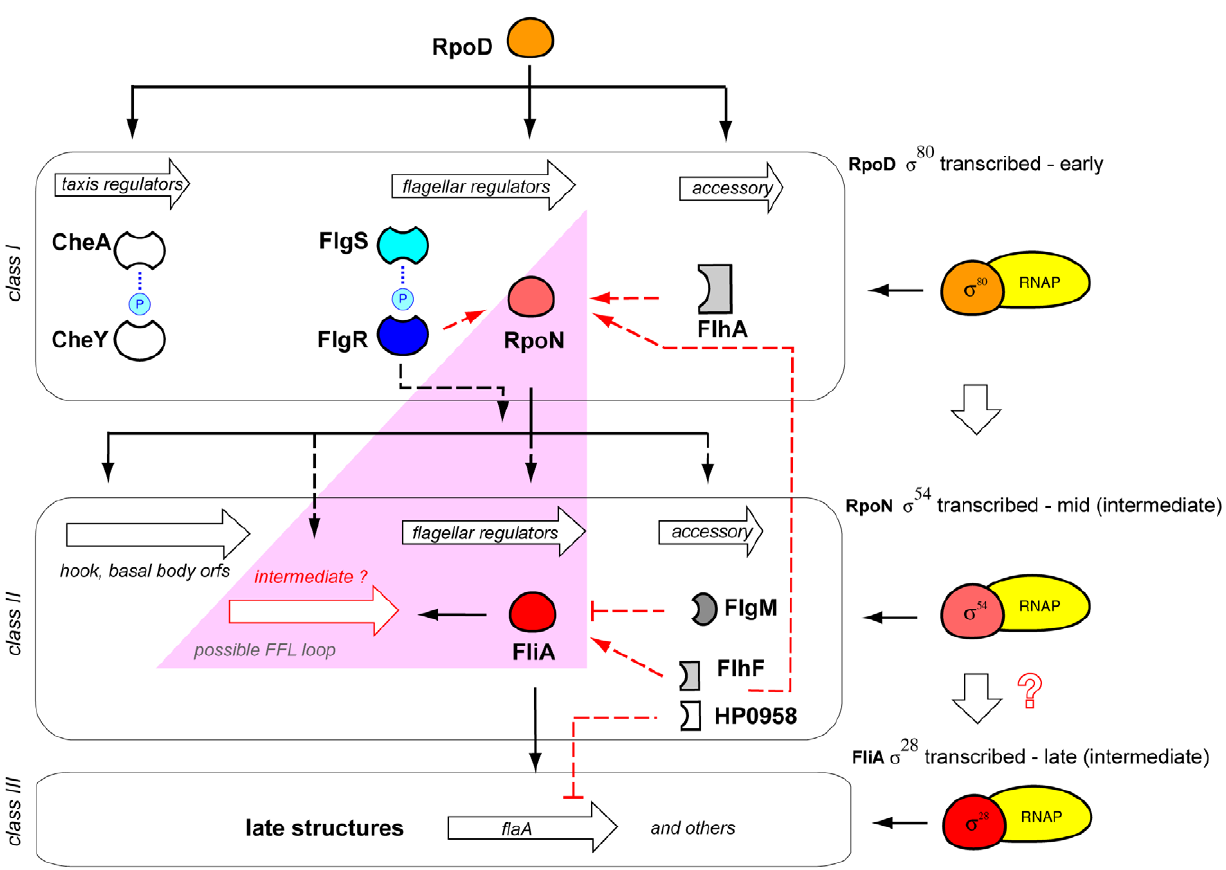
Figure 3. The flagellar biosynthesis module. RNAP, RNA polymerase; phosphorylation events are indicated by a light blue circle. CheAY, two component system involved in chemotaxis; FlgS, NtrB-like cytoplasmic histidine kinase; FlgR, NtrC-like response regulator. FlgM, anti- s 28 factor. FlhA, FlhF, HP0958: accessory factors. Note sequential activation of class I , II , and III due to s regulatory cascade. A pink triangle depicts a putative coherent FFL with OR logic proposed to control expression of intermediate class flagellar genes [32].